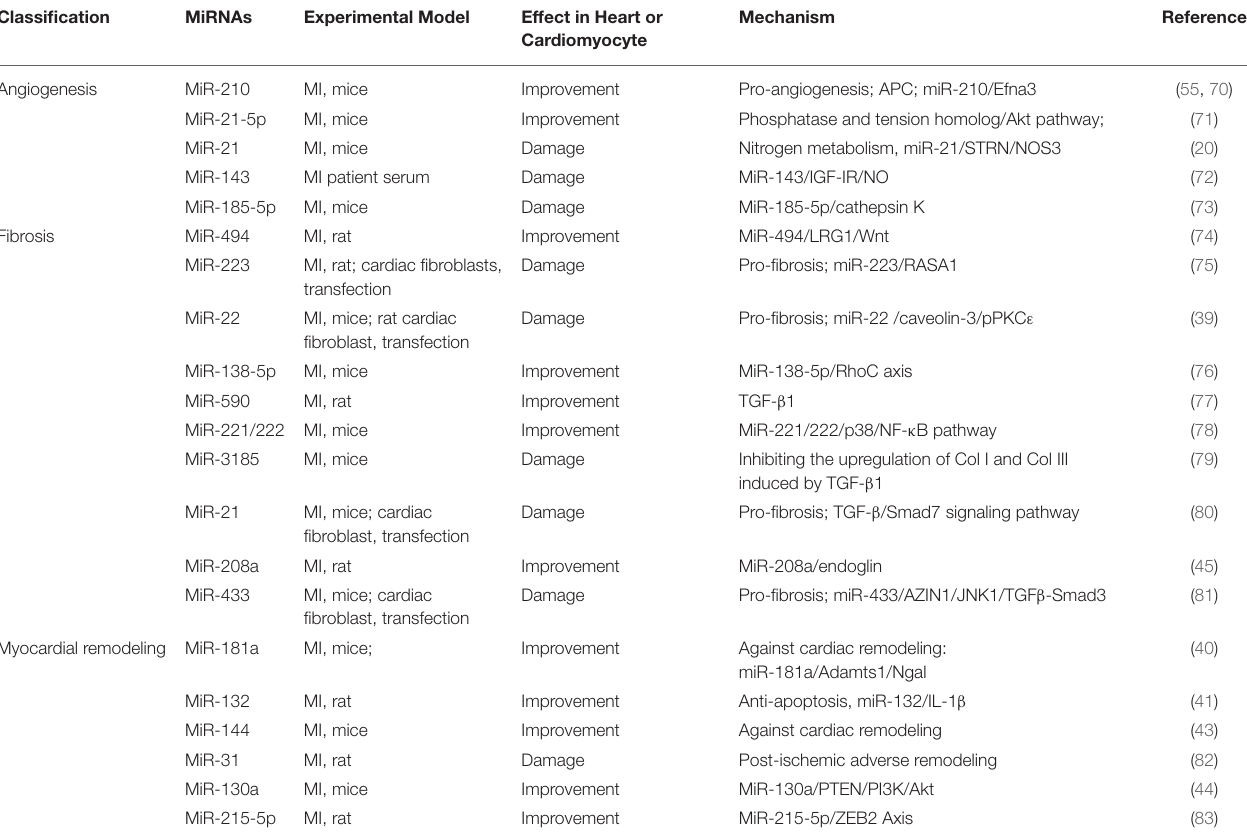
TABLE 5 | Summary of studies on miRNA regulating angiogenesis, fibrosis, and myocardial remodeling after MI in the past 5 years.